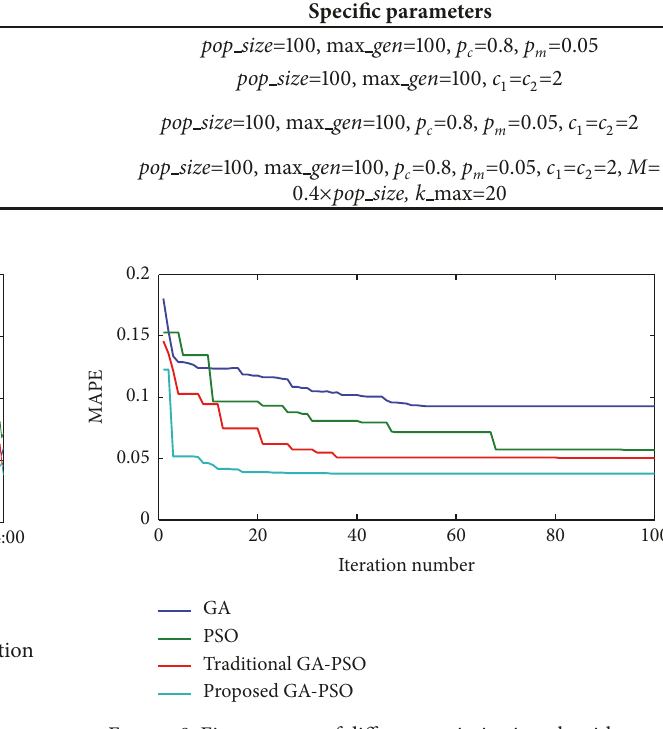
Figure 8: Fitness curve of different optimization